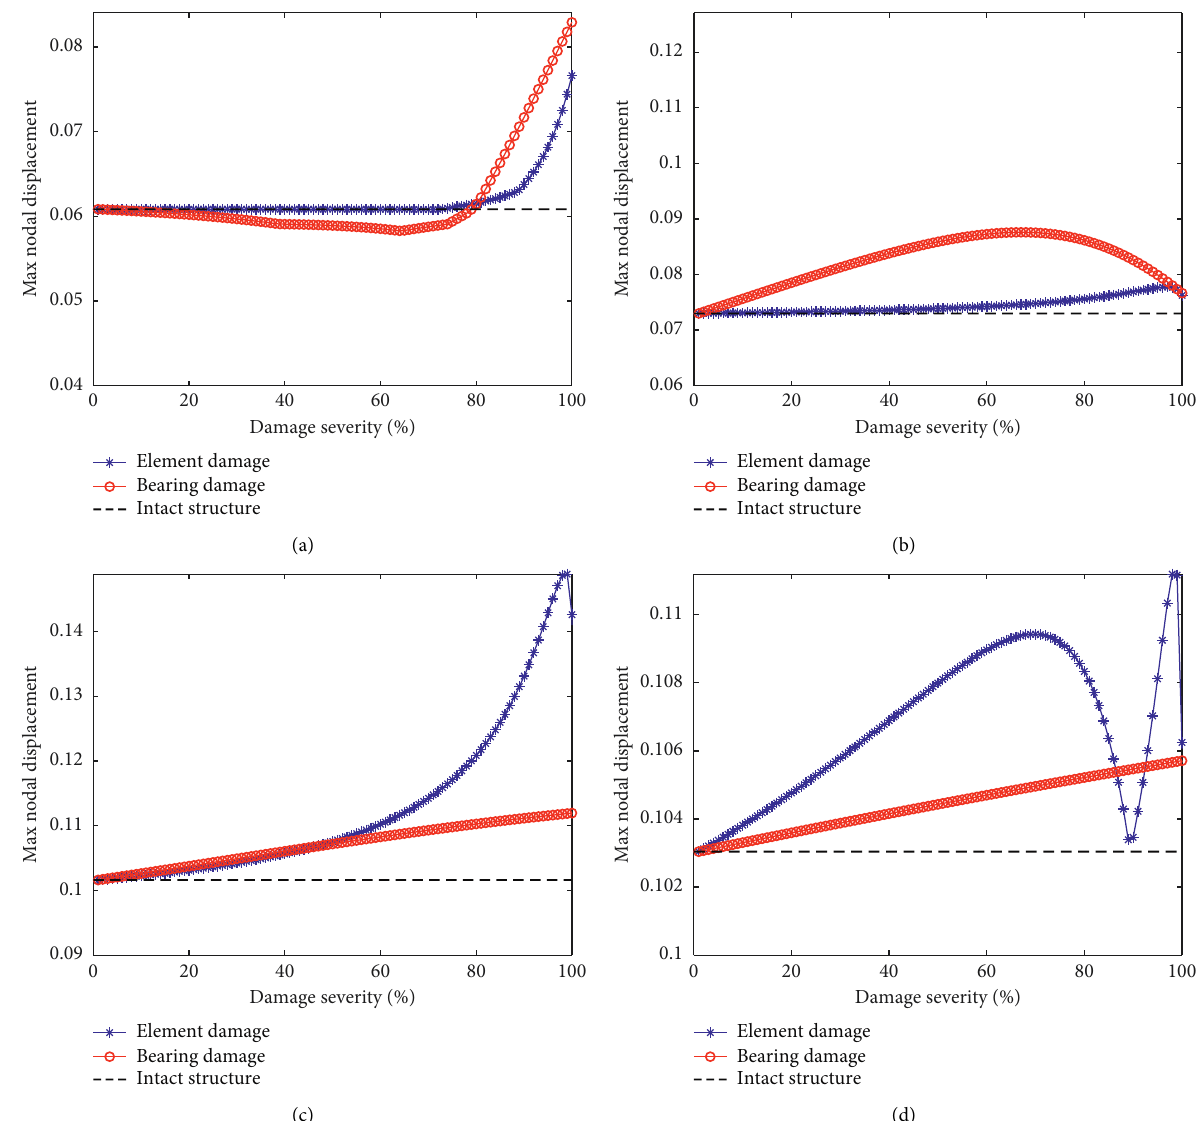
Figure 3: The (a) 1st, (b) 2nd, (c) 3rd, and (d) 4th change curves of max nodal displacement of each vertical modal shape under different damage severities in the structural element and